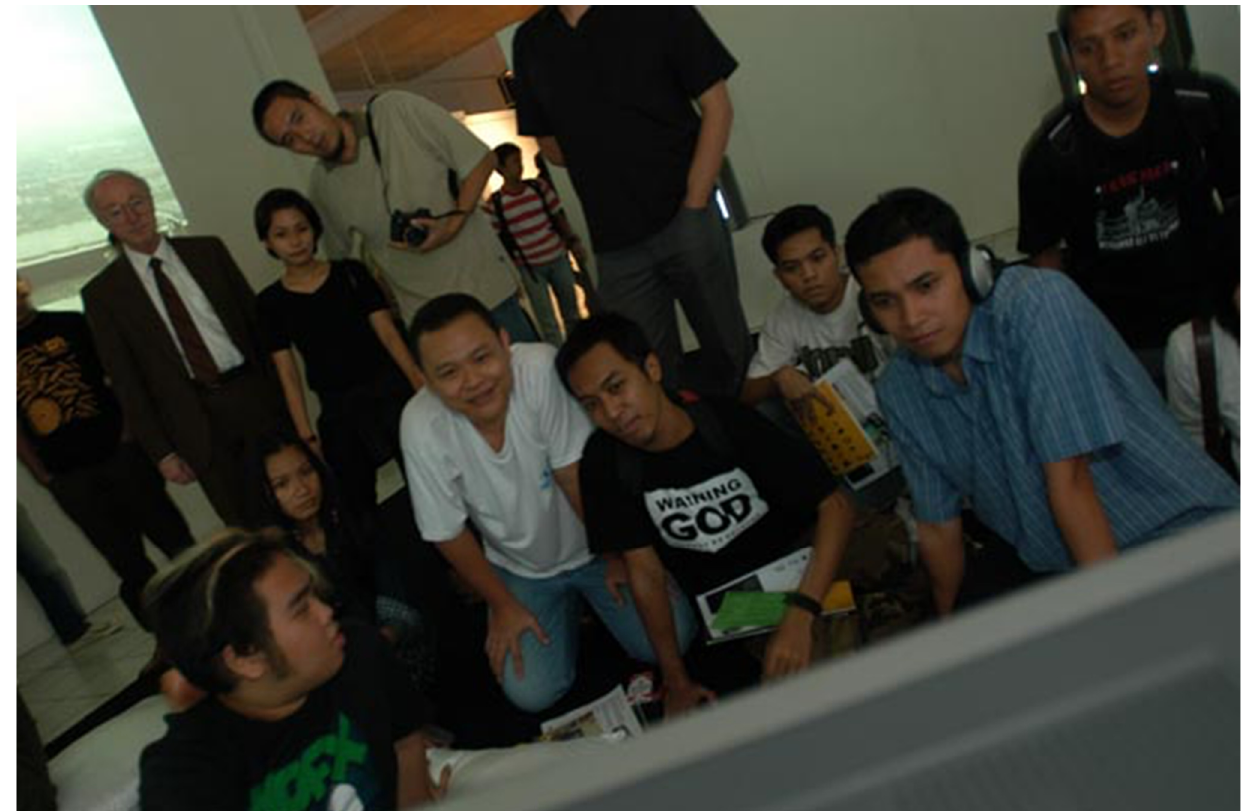
Figure 5. Audience enjoying the works in the first OK.Video , Jakarta Video Art Festival, Galeri Nasional Indonesia, 2003. Courtesy of ruangrupa.